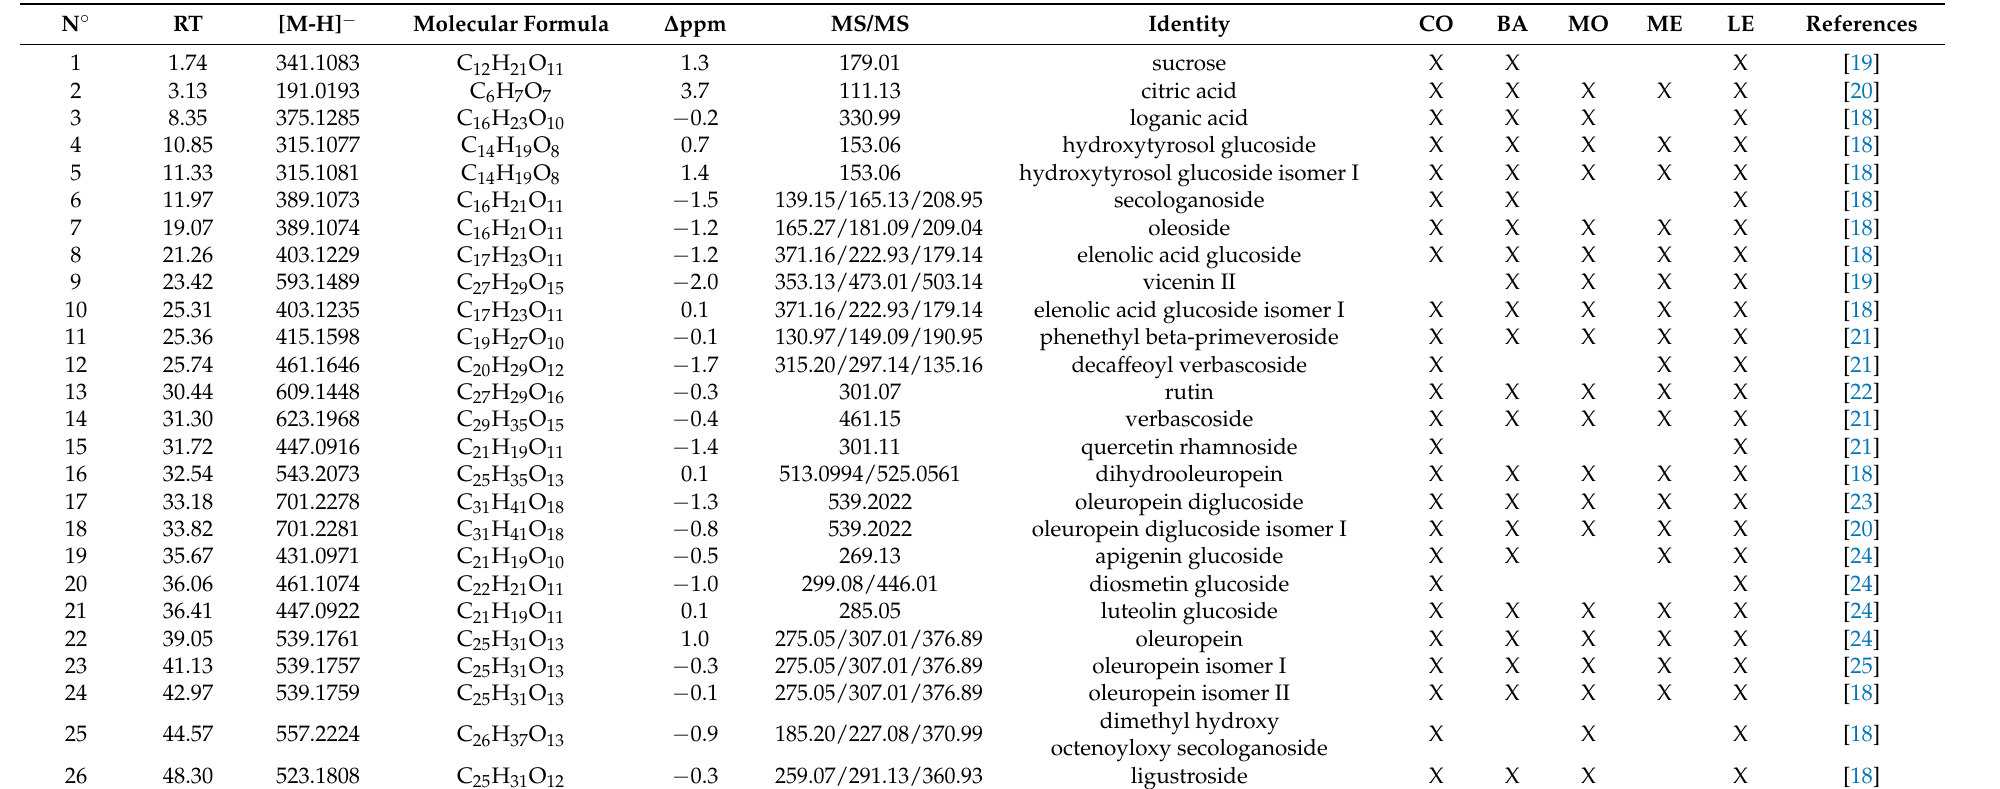
Table 1. Metabolites identified in olive leaves extracts by LC-ESI/LTQ-Orbitrap/MS and LC-ESI/LTQ-Orbitrap/MS/MS